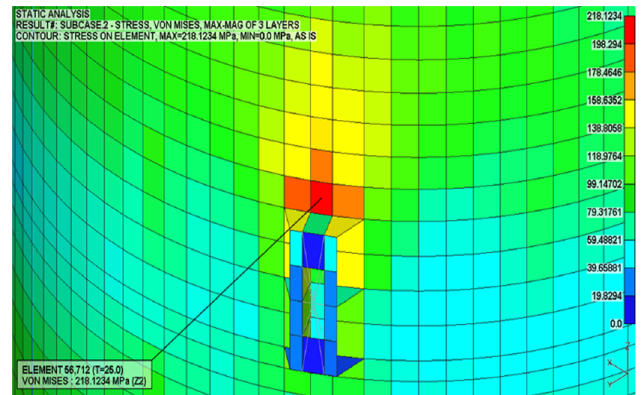
Figure 16. Maximum equivalent stress at fairlead (close up). Table 15. Maximum equivalent stresses of the plates.